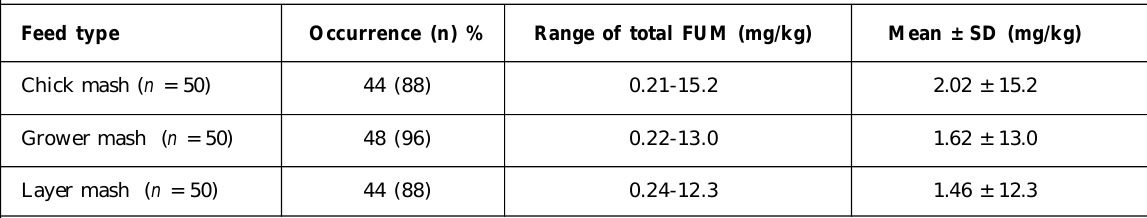
Table 5: Fumonisin levels of layer feeds grouped by feed type in Nairobi County, Kenya Feed type